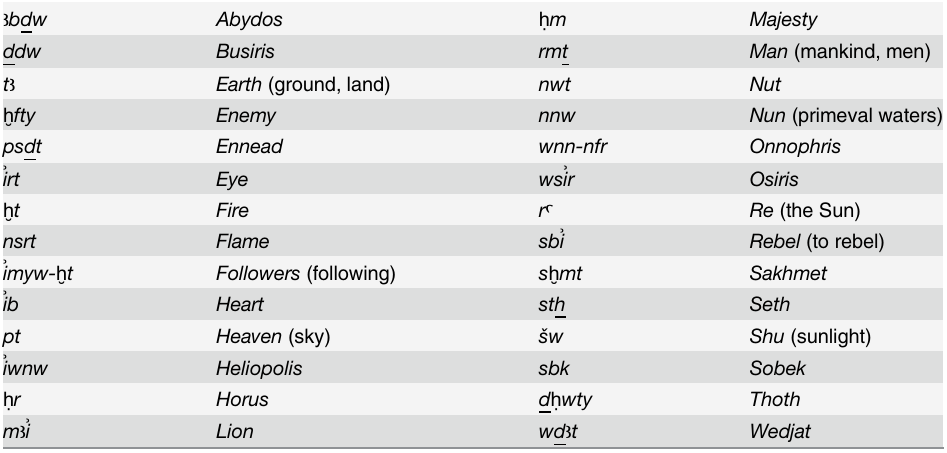
Table 1. List of SWs in Ancient Egyptian language.